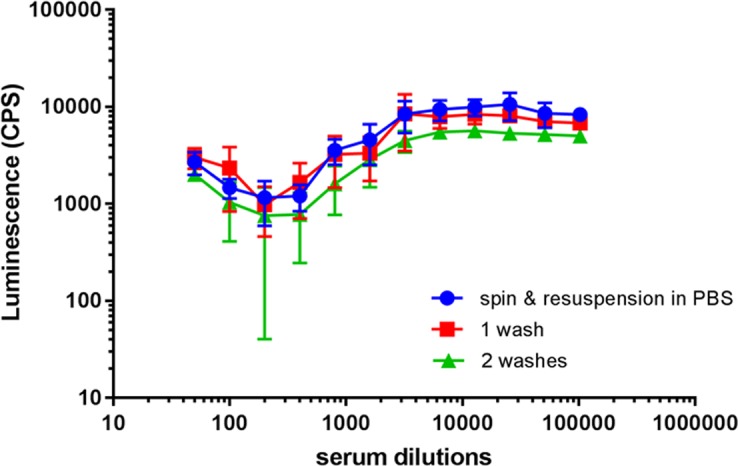
L-SBA optimization to circumvent serum interference with luminescence readout.Bactericidal reaction was tested using C. freundii in the presence of 5% BRS and serial dilutions of HI standard serum. At the end of the SBA reaction, we performed: a. one spin and resuspension of bacterial pellets in PBS; b. one wash; c. two washes in PBS, before measuring luminescence. Average luminescence signals and standard deviations are shown from three independent experiments, for each condition (for some points the error bars are not visible because shorter than the symbols).